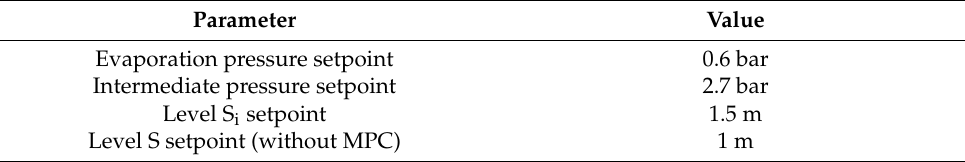
Table 2. Setpoint values implemented in the system.